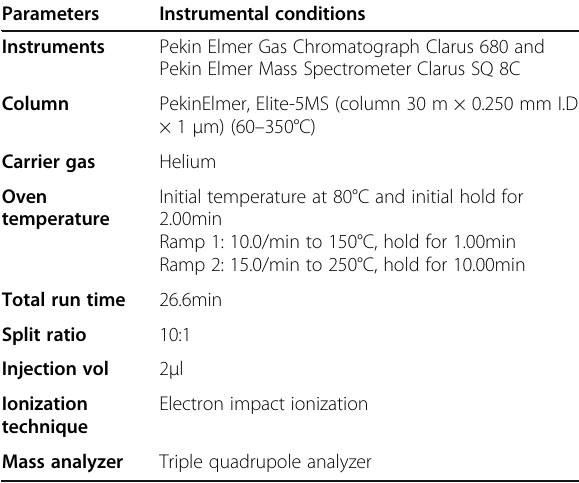
Table 1 GC-MS chromatographic